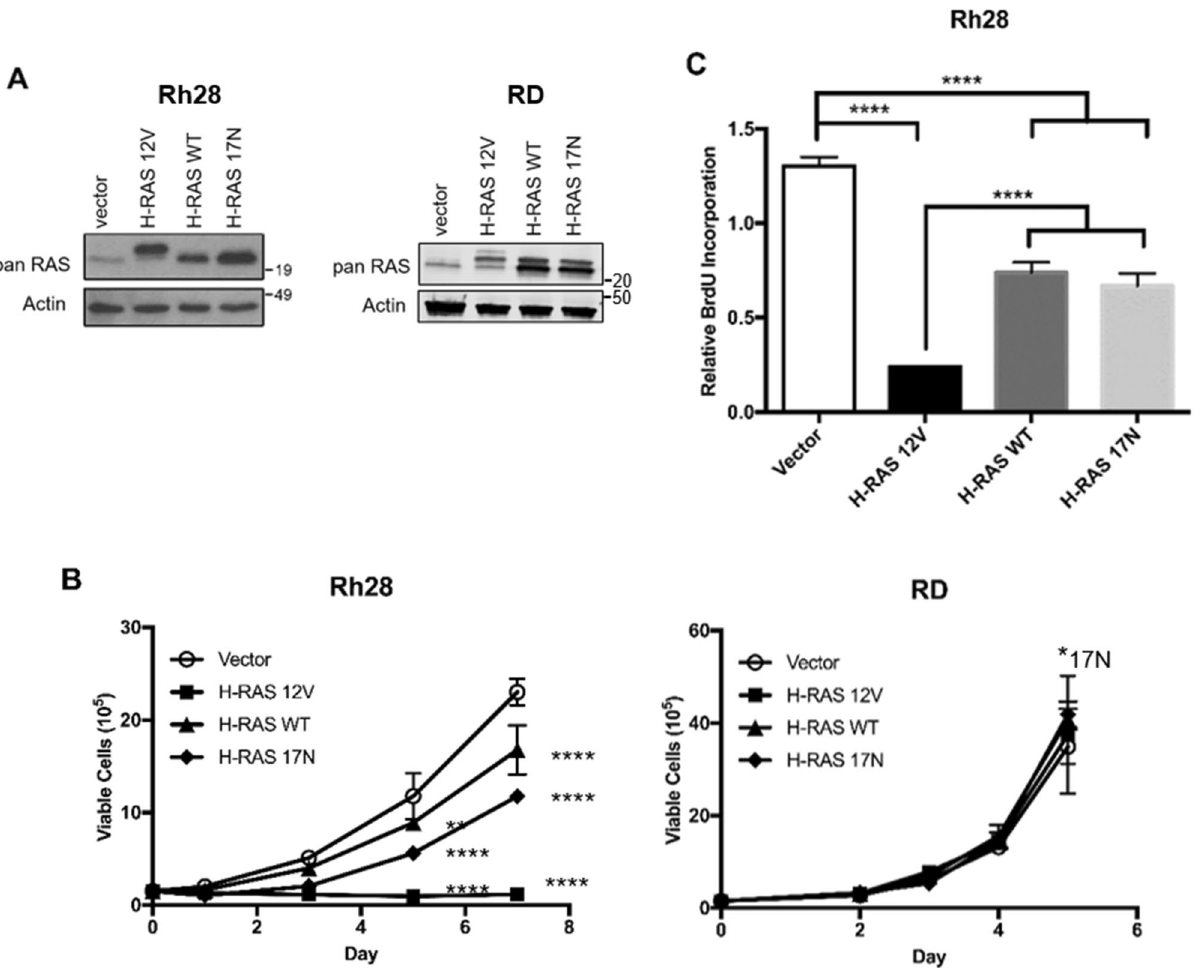
Figure 2. Stable expression of oncogenic H-RAS inhibits growth and decreases proliferation in Rh28 aRMS cells. ( A ) H - RAS mutants including oncogenic H-RAS (H-RAS 12V), wild type H-RAS (H-RAS WT), and dominant negative H-RAS (H-RAS 17N) were stably expressed in Rh28 aRMS and RD R-eRMS cells. RAS expression was measured by immunoblot using a pan-RAS antibody with actin as loading control. The H-RAS V12 band runs higher on SDS-PAGE because it contains an N-terminal FLAG tag. ( B ) Expression of oncogenic H-RAS caused growth suppression in Rh28 but not RD cells. Wild type and dominant negative H-RAS also impaired growth in Rh28 cells, though not to the same degree as oncogenic H-RAS. ( C ) Rh28 cell proliferation decreased in response to expression of each H-RAS mutant, especially oncogenic RAS, as measured by BrdU assay. (*p < 0.05; **p < 0.01; ****p <